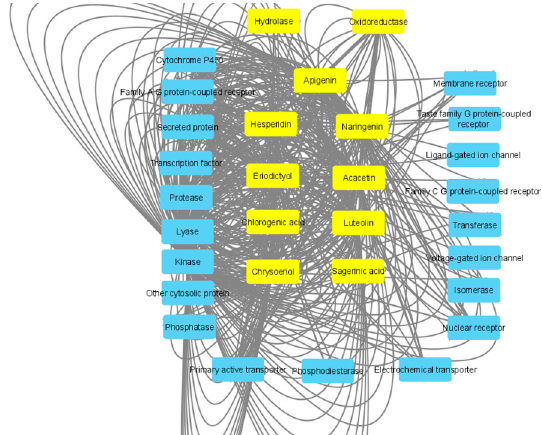
Figure 9. Structure of eriodictyol, acacetin, hesperidin, sagerinic acid, naringenin, luteolin, chloro- genic acid, chrysoeriol and apigenin.